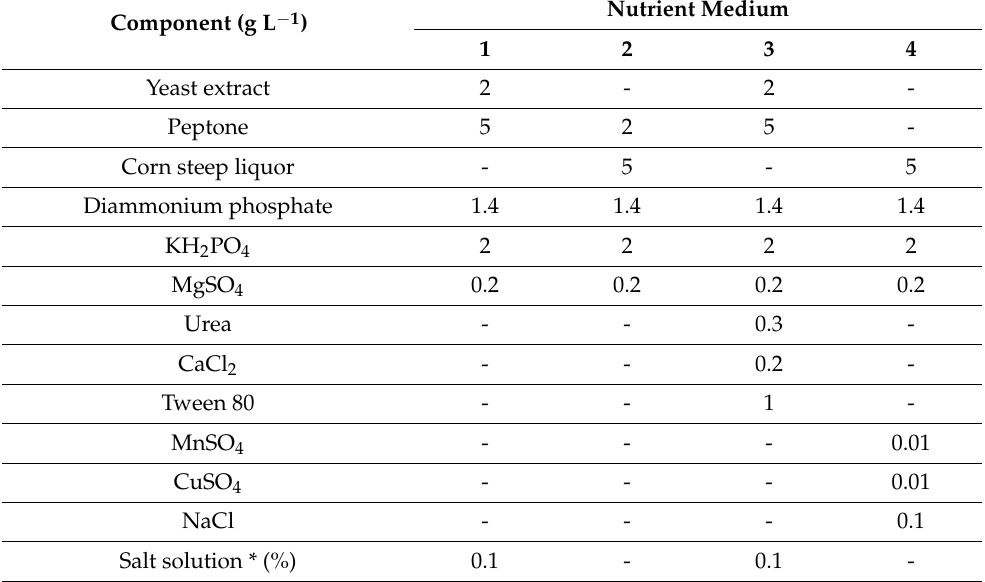
Table 1. Media composition used for cultivations of